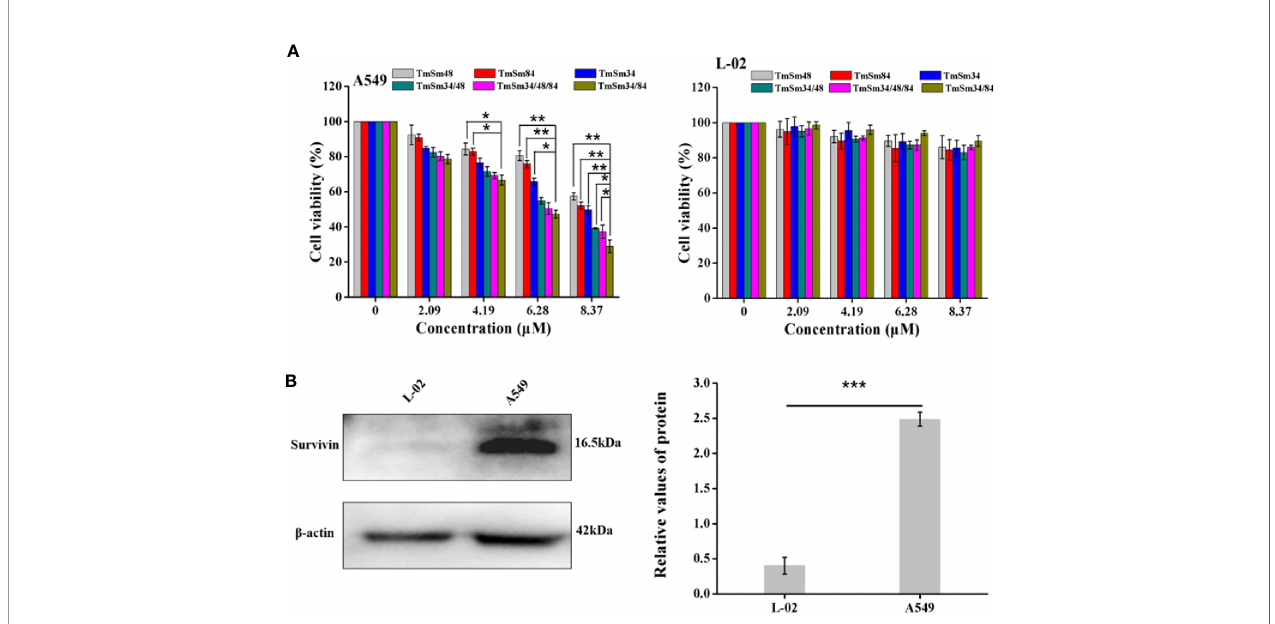
FIGURE 2 | Cytotoxicity assay of TmSm proteins against A549 and L-02 cells. (A) The viabilities of A549 and L-02 cells were measured after incubating with different TmSm proteins of the same concentrations gradient (0, 2.09, 4.19, 6.28, and 8.37 m M) for 24 h. (B) Survivin expression was determined by Western blot in A549 and L-02 cells. Data were expressed as mean ± SD ( n = 3). * P < 0.05, ** P < 0.01, and *** P <